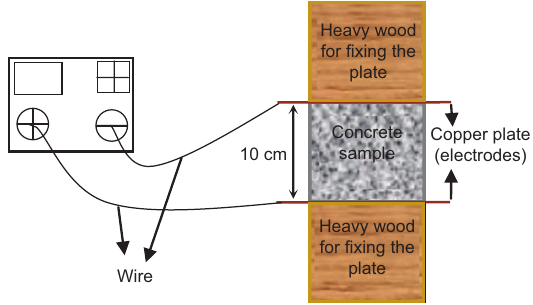
Figure 1 Schematic of resistivity test setup.